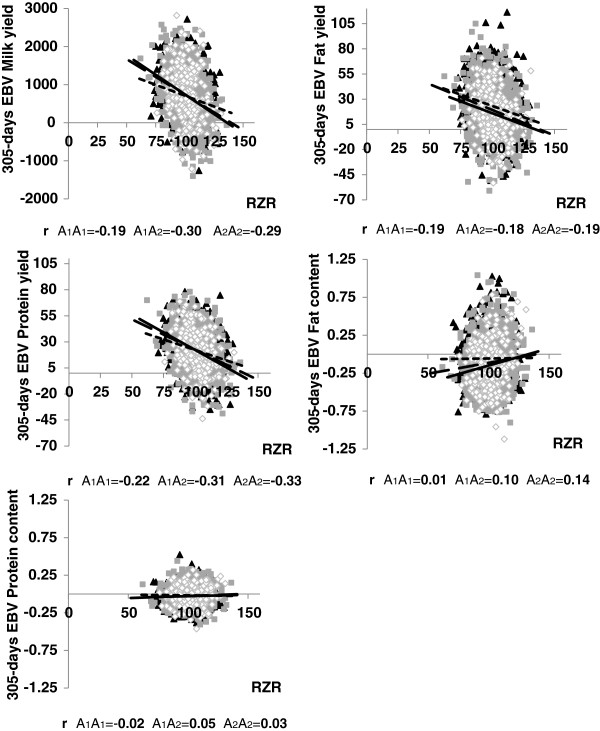
Genotypic correlations in marker genotype classes between EBVs of production traits and RZR for marker ARS-BFGL-NGS-57448 on chromosome 27. EBV: estimated breeding value; RZR: (fertility index, summarizing all fertility traits); short dashed line and filled triangle is genotype A1A1; long dashed line and filled square is genotype A1A2; solid line and empty diamond is genotype A2A2. A2 is the minor allele (MAF 0.35).